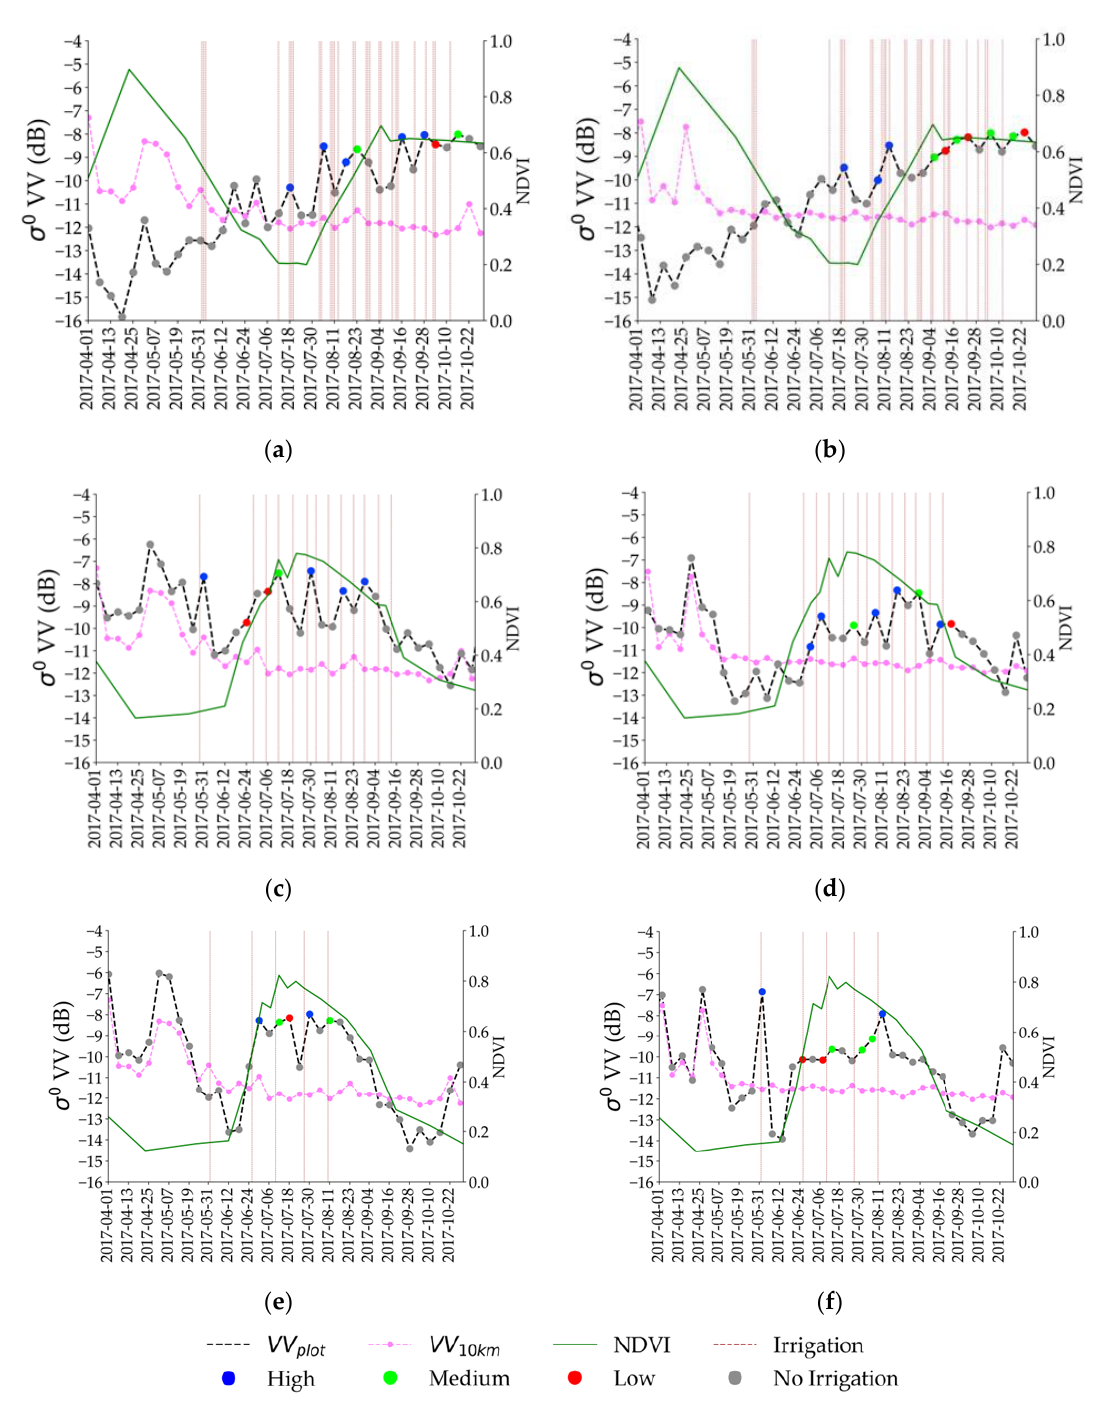
Figure 5. Irrigation detection over P1 ( a , b ), P2 ( c , d ), and P3 ( e , f ) using the morning SAR acquisition ( a , c , e ) and the evening SAR acquisition ( b , d , f ), in Montpellier, France. SAR VV signal at plot scale in dashed black line and VV at grid scale in dashed pink line. Points with blue, green and red are irrigation points detected on SAR signal at high, medium and low certainty respectively. The green line represents the normalized di ff erential vegetation index (NDVI). High, medium and low correspond respectively to detected irrigation events with high, medium and low